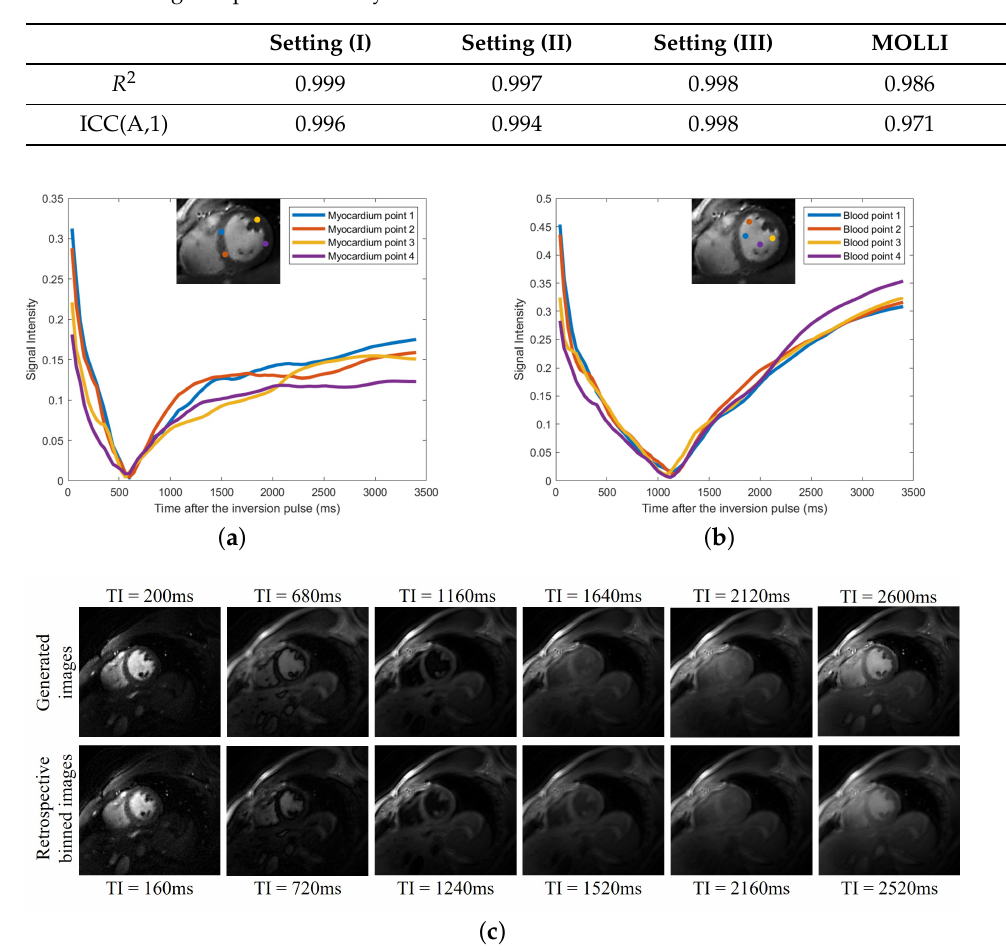
Table 2. The correlation analysis between the estimated T 1 values and the reference T 1 values for different settings for phantom study.